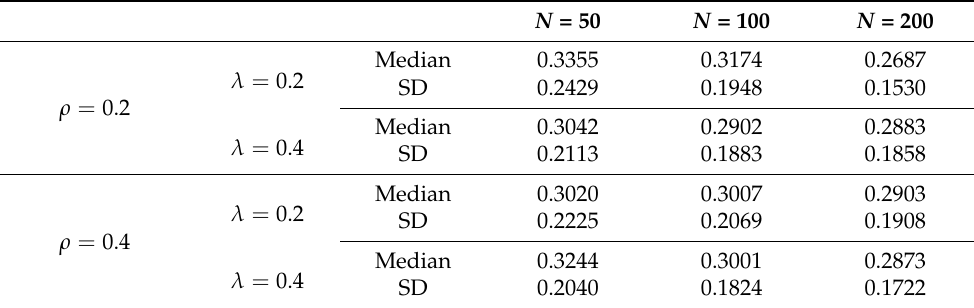
Table 4. The medians and SDs of MADEs for nonparametric estimates under the model (12) with T =